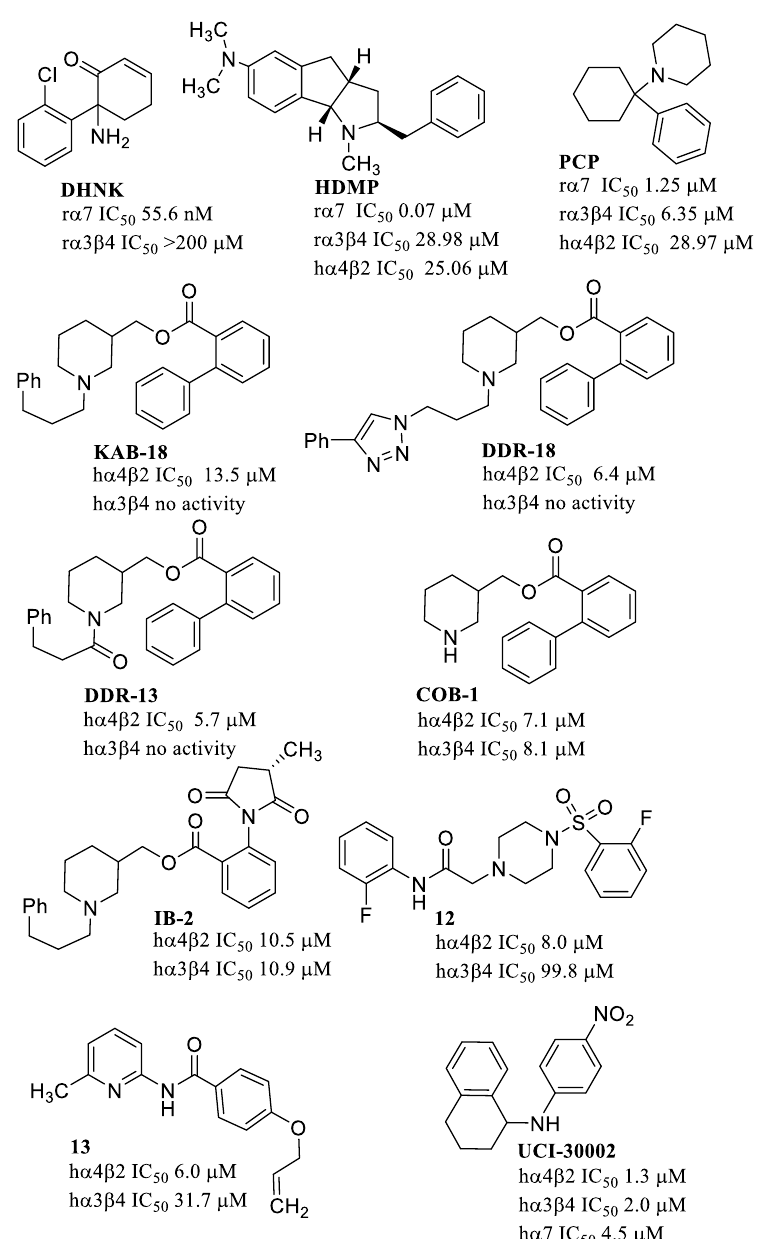
Figure 16. Negative allosteric modulators (NAMs) of different nAChR subtypes. 1,2,3,3a,4,8b-haxahydro-2-benzyl-6- N,N -dimethylamino-1-methylindeno[1,2-b]pyrrole (HDMP), obtained by a conformationally restricted analogs of nicotine [125], shows 350-fold higher inhibitory potency on α 7 than on α 3 β 4 and α 4 β 2. HDMP is thus an example of NAM with a good selectivity profile towards the α 7 nAChRs. Phencyclidine (PCP) is an α 7 NAM 18-fold less potent than HDMP with a different selectivity profile. In fact, PCP inhibits the α 7 nAChR with potency 23-fold higher than that at the α 4 β 2 nAChR, but similar as that for the α 3 β 4 nAChR [126].